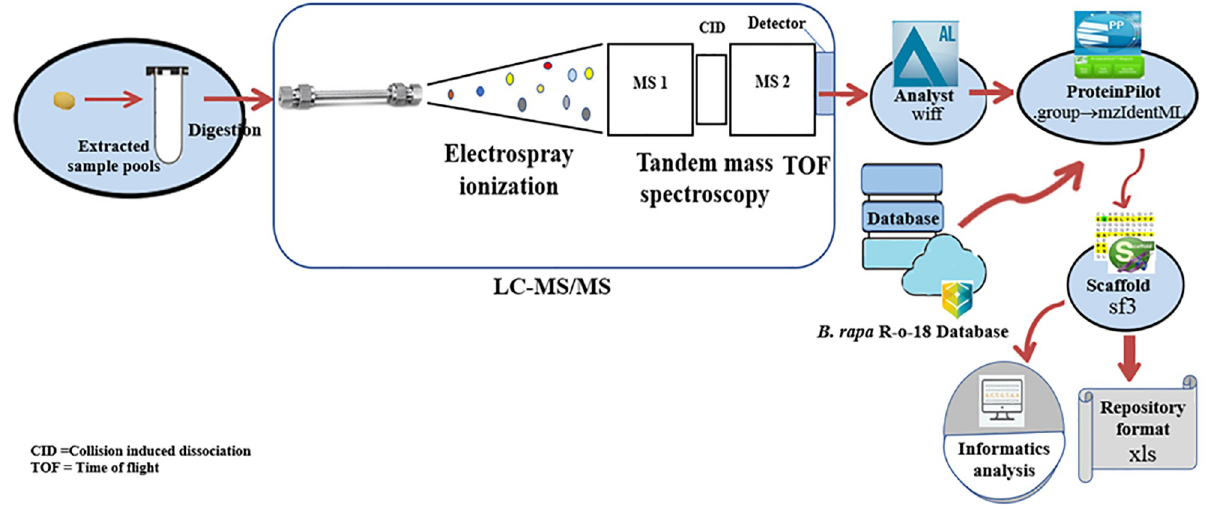
Fig 1. Overview graph of proteomics pipeline. The LC-MS/MS proteomics workflow is illustrated using ovals to represent the key steps within the workflow and the arrows connecting them.